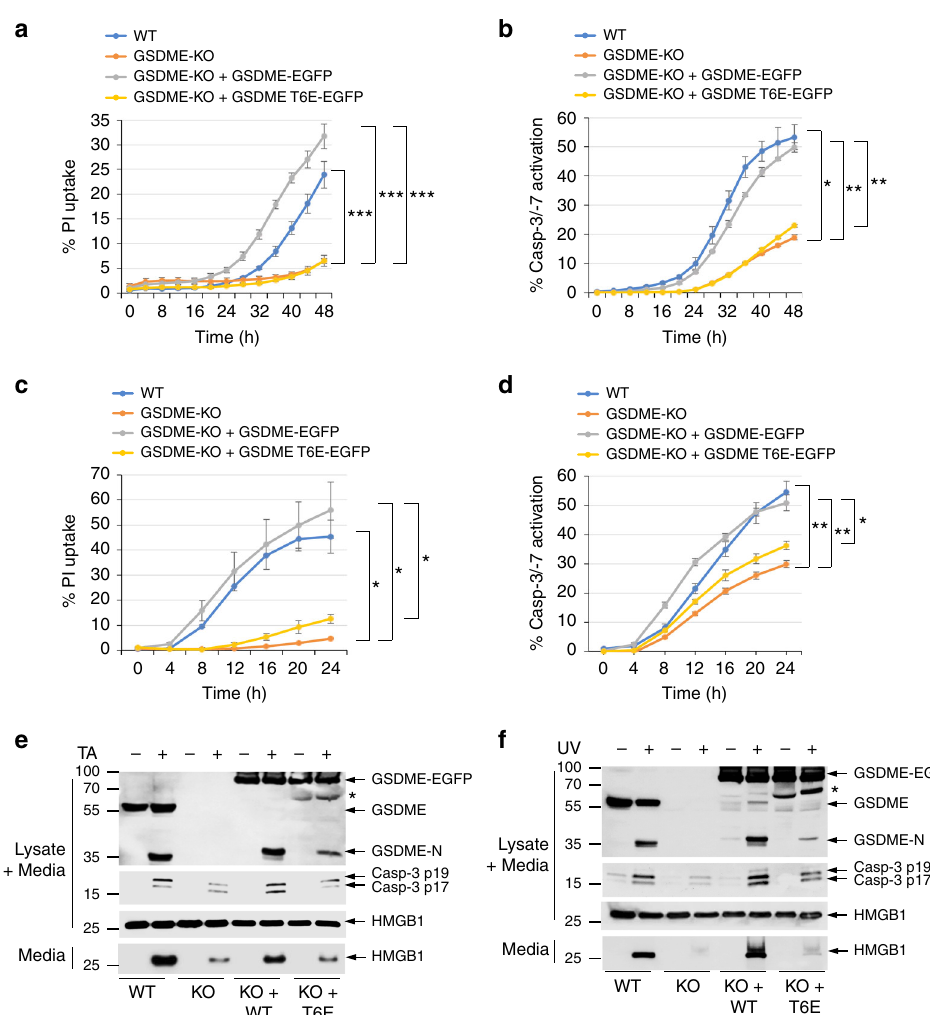
Fig. 3 Pyroptosis and caspase-3 activation are compromised in GSDME-T6E-expressing CEM-C7 cells. a – d Propidium iodide (PI) uptake ( a , c ), and active caspase-3 staining ( b , d ) in CEM-C7 cells (wild-type (WT), GSDME-knockout (KO), or GSDME-KO reconstituted with WT GSDME-EGFP or GSDME-T6E- EGFP) treated with triamcinolone acetonide (TA) ( a , b ) or ultraviolet (UV) ( c , d ) as measured on the IncuCyte over time. e , f Immunoblots of GSDME, active caspase-3 p17/p19 and high-mobility group box 1 (HMGB1) in combined cell lysates plus media, or HMGB1 released in culture media (media) of WT (WT), GSDME-KO (KO), or GSDME-KO reconstituted with WT GSDME-EGFP (KO + WT) or GSDME-T6E-EGFP (KO + T6E) CEM-C7 cells treated with TA ( e ) or UV ( f ). *Indicates GSDME-EGFP degradation product. Results are representative of at least three independent experiments performed in duplicate or triplicate. Error bars represent S.D. Student ’ s t -test, * p < 0.05, ** p < 0.005, *** p